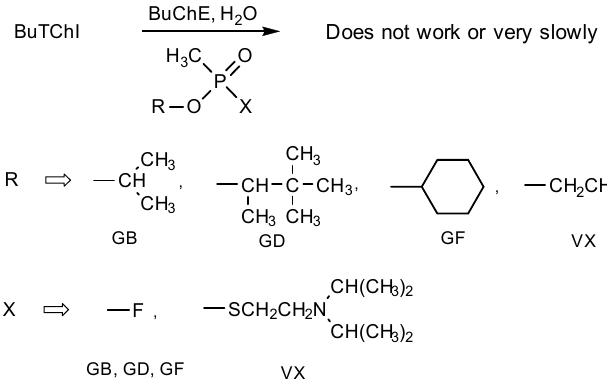
Figure 2. Overall reaction schema.